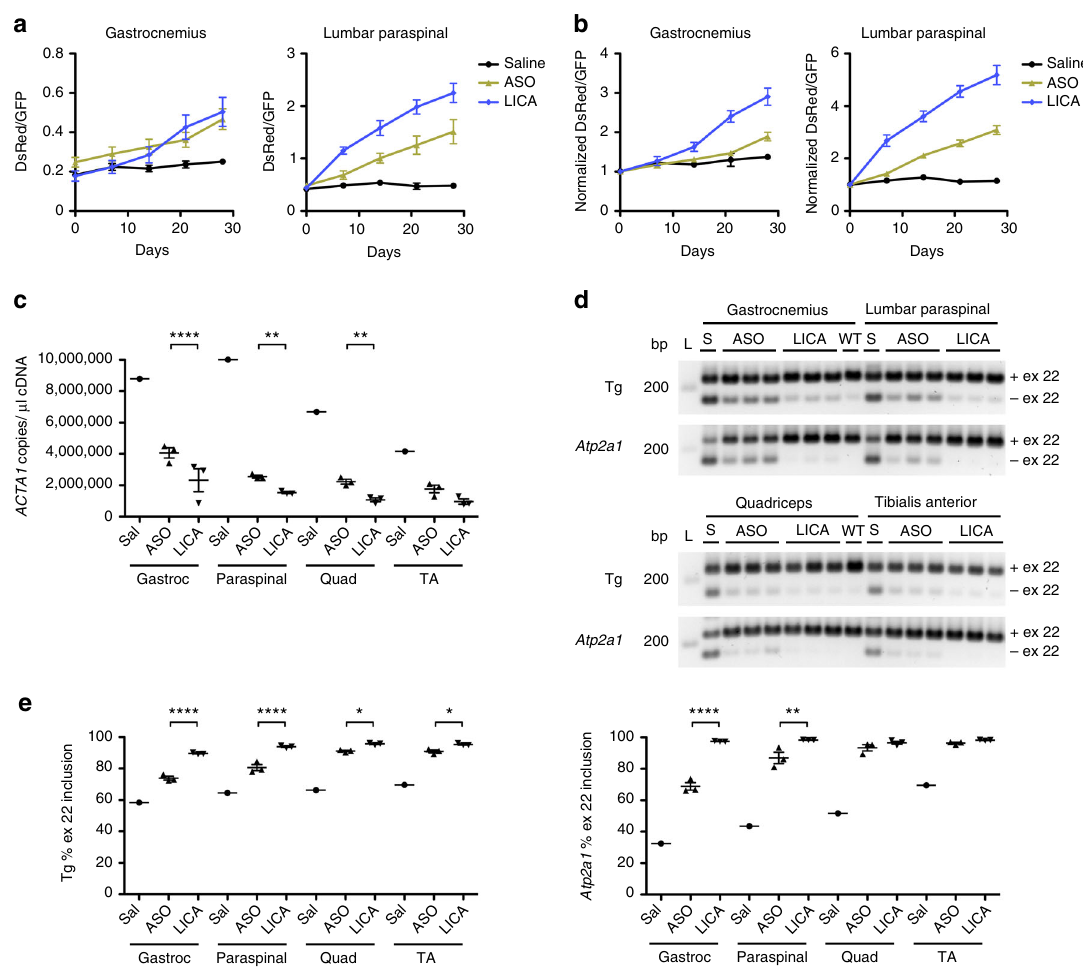
Fig. 7 In vivo comparison of LICA and the unconjugated parent ASO. We treated TR; HSA LR mice with LICA oligo 992948 (LICA) or ASO 445236 (ASO), which is the unconjugated parent of LICA oligo 992948 that targets the identical ACTA1 sequence 8 . ASOs were administered by subcutaneous injection of 12.5 mg/kg twice weekly for 4 weeks ( N = 3 each) (eight total doses). Treatment with saline ( N = 1) served as a control. a DsRed/GFP quantitative fl uorescence in gastrocnemius (left) and lumbar paraspinal muscles (right) by serial in vivo spectroscopy in mice treated with saline (black circles), ASO (yellow triangles), or LICA (blue diamonds). Error bars indicate mean ± s.e.m. b Due to the higher baseline DsRed/GFP values in the gastrocnemius of mice randomized to receive the unconjugated ASO, we normalized each measurement of quantitative fl uorescence in the gastrocnemius (left) and lumbar paraspinal muscles (right) to the Day 0 value, so that the Day 0 value for each muscle = 1. Error bars indicate mean ± s.e.m. c ddPCR quantitation of ACTA1 transcripts (copies per microliter cDNA) in muscles collected at imaging Day 28. **** P < 0.0001; ** P < 0.01; two-way ANOVA. d RT-PCR analysis of exon 22 alternative splicing of the transgene (Tg) and mouse Atp2a1 in gastrocnemius, lumbar paraspinal, quadriceps, and tibialis anterior (TA) muscles collected on imaging Day 28. FVB WT gastrocnemius served as a control. L DNA ladder, bp base pairs. e Quantitation of splicing results in d . Error bars indicate mean ± s.e.m. **** P < 0.0001; ** P < 0.01; * P < 0.05; two-way